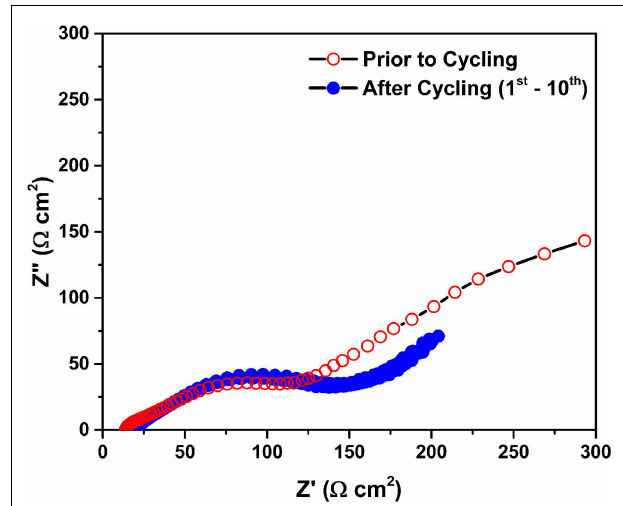
FIGURE 2 | Nyquist plots of the Mg/MnO 2 cell described in Figure 1 . All impedance data were collected under open circuit voltage (OCV) within the frequency range of 2MHz~0.1Hz. Unshaded and shaded circles denote the impedance data collected prior to and after cycling,